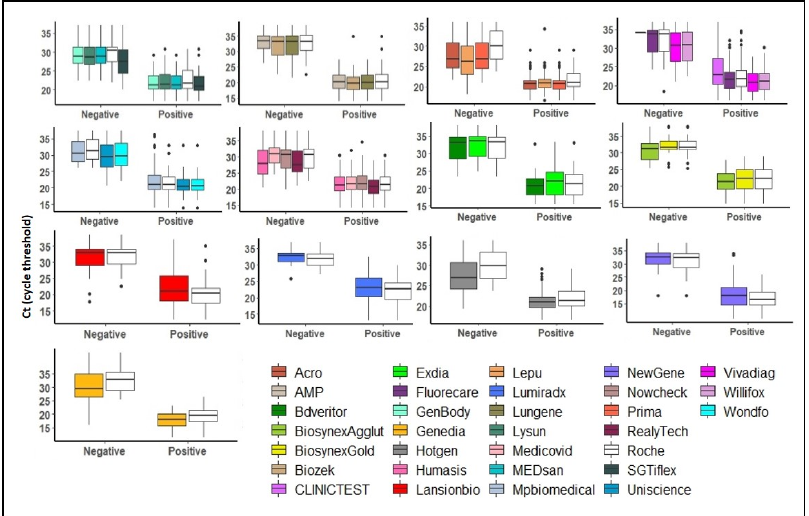
Figure 1. Box-plots of Ct values distributions according to different batches of validation series. Figure 1 legend. RATs were grouped according to the validation series. For each series, there was one internal reference (Standard Q ® , white box-plot). Black solid lines represent the Ct medians, box-plots and whiskers represent the Ct values distribution. RATs results are displayed on the x -axis: Negative or Positive. Cycle thresholds (Ct) are shown on the y -axis.